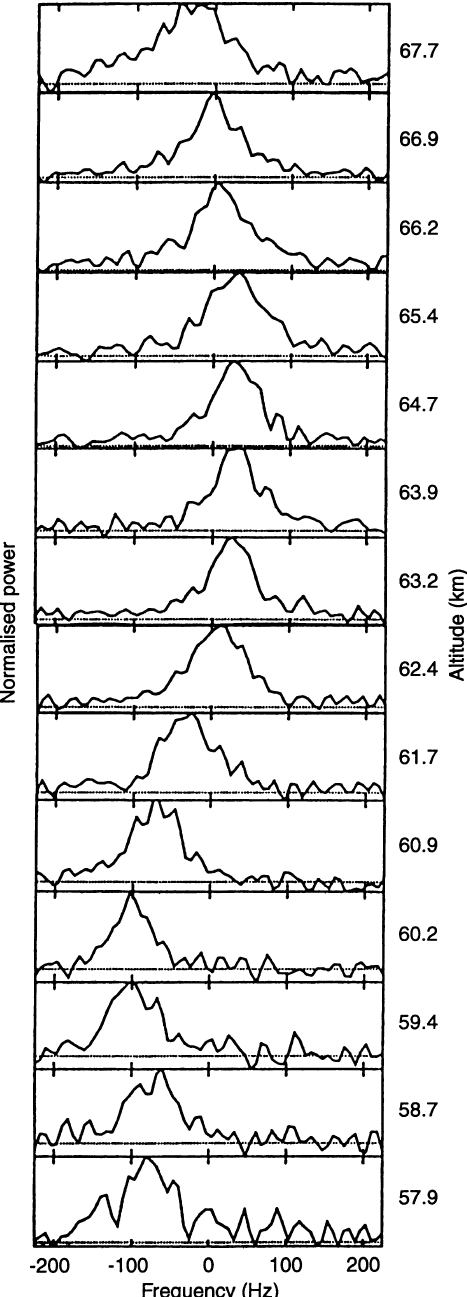
Fig. 7. Spectra measured by the UHF radar between 58 and 68 km altitude at an elevation angle of 45 (cid:176) at 1330 UT on 20